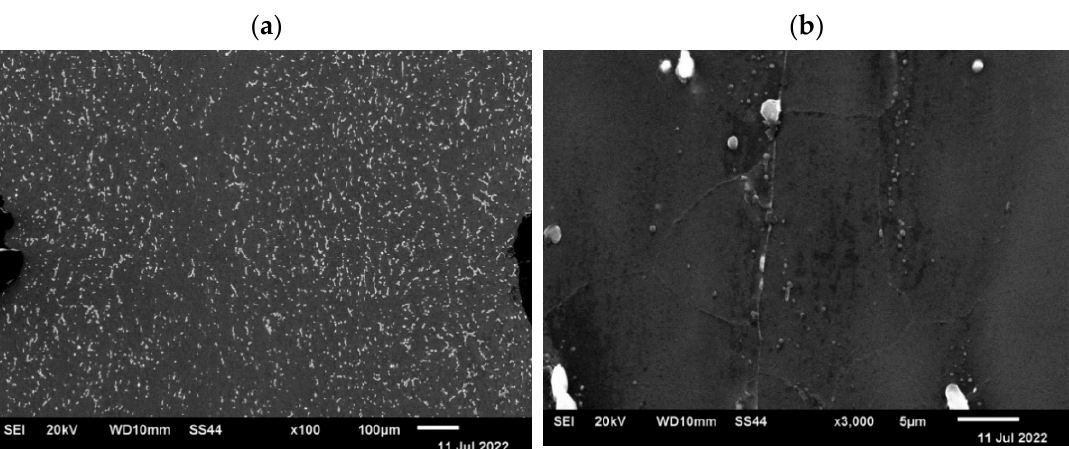
Figure 21. The microstructure of the sample with a square cross-section in the axis area after plastic deformation disclosed in the SEM analysis: ( a )—magnification ×100; ( b )—magnification ×3500.